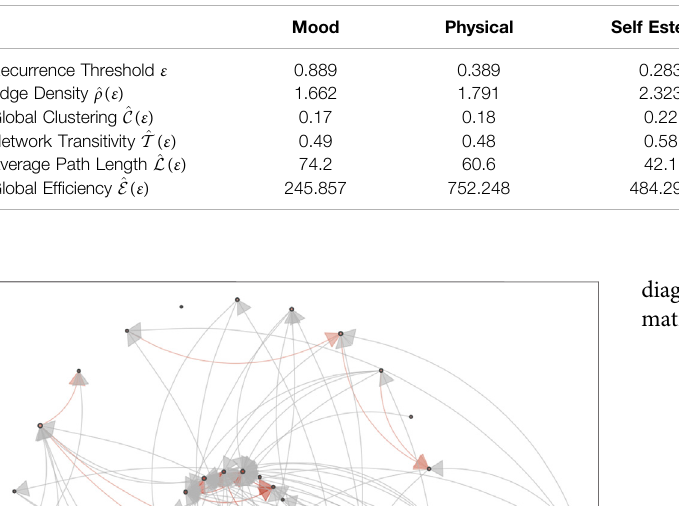
TABLE 1 | Global recurrence network measures.